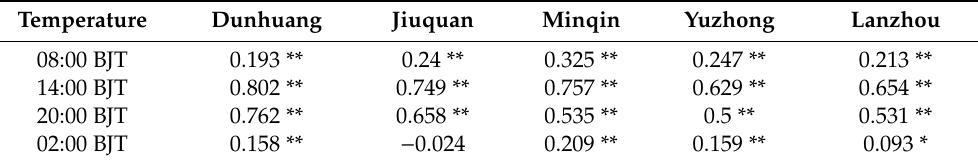
Table 1. Correlation between daily boundary layer height and temperature in each representative region.